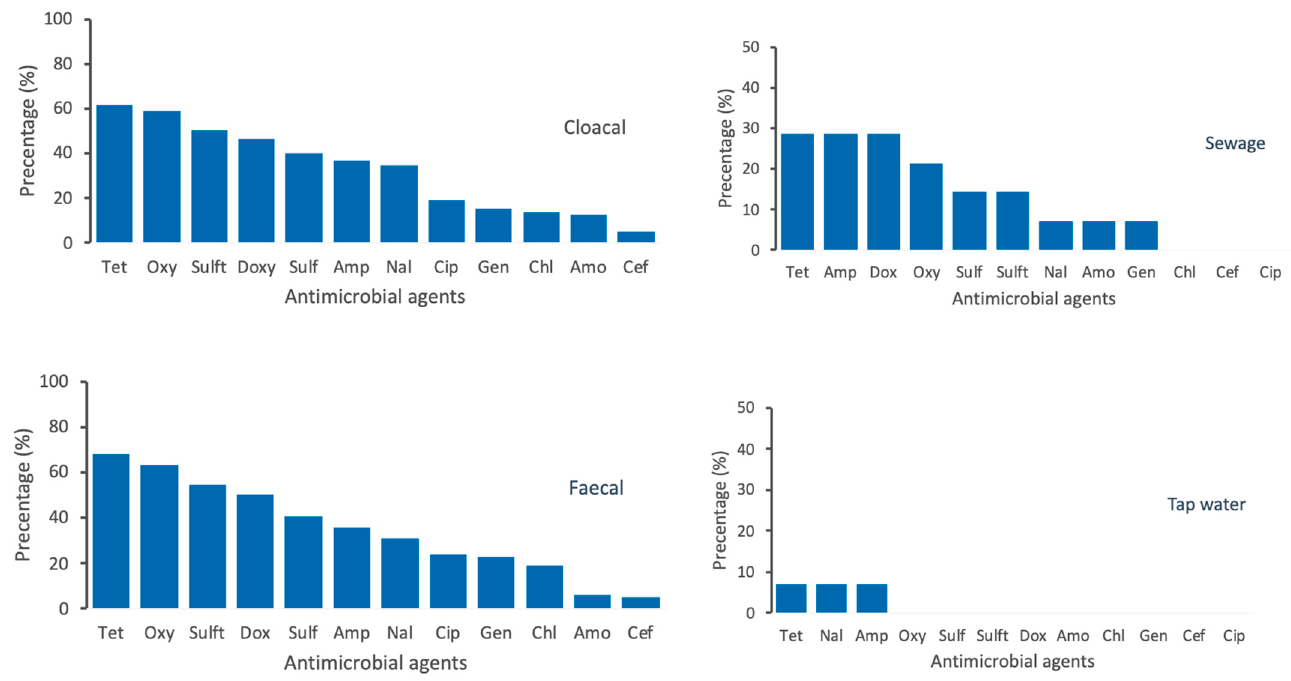
Figure 3. Percentage of antimicrobial-resistant Escherichia coli isolated from four epidemiological samples that include cloacal, faecal, tap water, and sewage collected from poultry farms. Data are the number of poultry samples (n = 371) in three states of east coast peninsular Malaysia. Tet: Tetracycline; Oxy: Oxytetracycline; Sulft: Sulfamethoxazole/trimethoprim; Sul: Sulfamethoxazole; Dox: Doxycycline; Amp: Ampicillin; Nal: Nalidixic acid; Chl: chloramphenicol; Gen: Gentamycin; Cip: Ciprofloxacin; Amo: amoxicillin and Cef: cefoxitin.